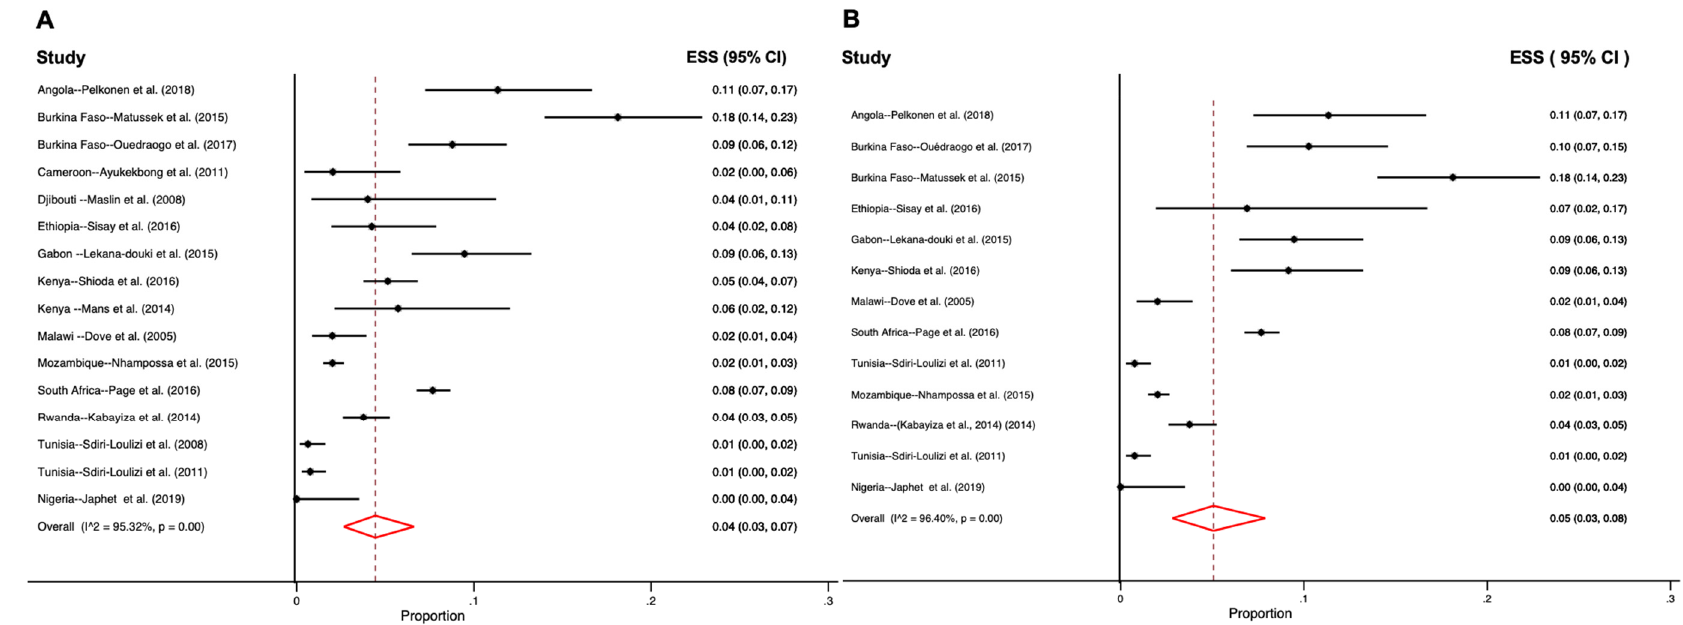
Figure 2. Forest plots for pooled prevalence by age estimated with random-effects meta-analyses ( A ) all ages and ( B ) under five years of age. (ESS – estimated effect size or proportion of cases; I 2 – heterogeneity statistic; CI – confidence interval).